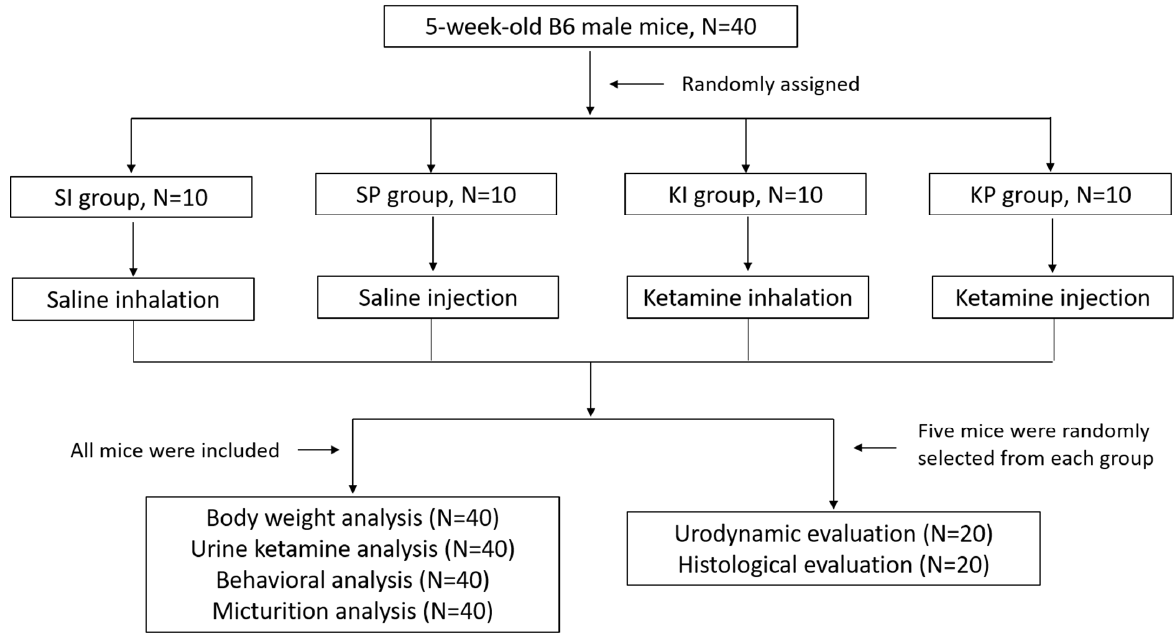
Figure 1. Flowchart of case distribution and interventions.